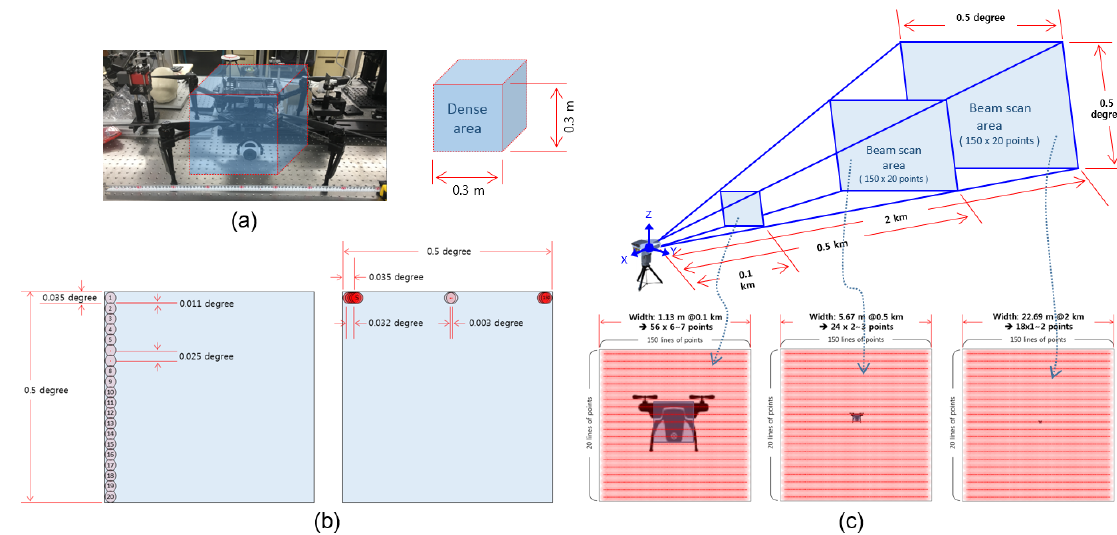
Figure 5. Characteristics analysis of LADAR laser beam and calculation for equivalent target projection points. ( a ) Dense area of target, ( b ) beam divergence and intersection, ( c ) detectable target projection points.